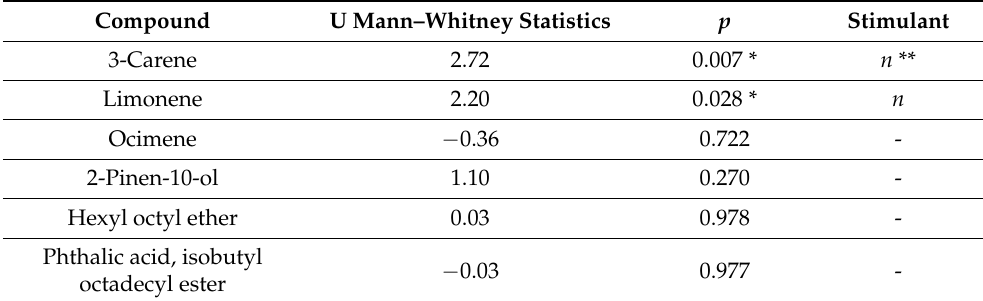
Table 4. Statistical evaluation of the differences between concentrations of VOCs emitted by brood taken from healthy and infected with P. larvae colonies. In both types of samples, the brood showed no clinical signs of P. larvae infection. Results of the U Mann-Whitney test with